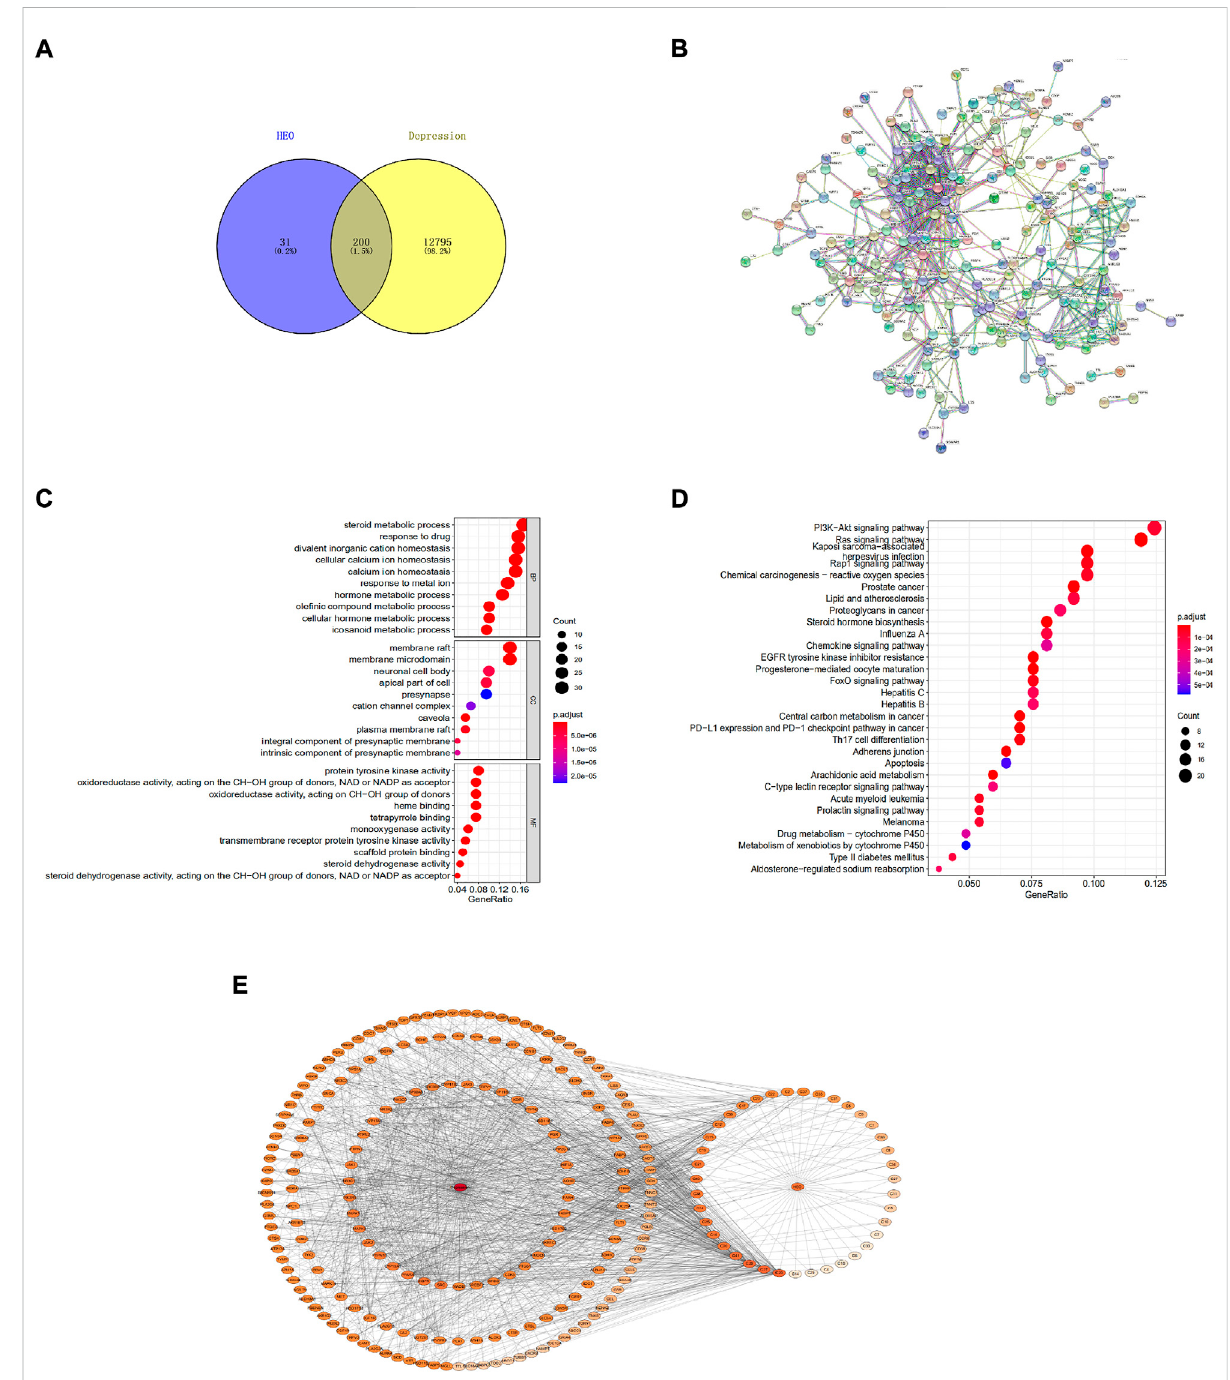
FIGURE 7 The network pharmacology method was adopted to predict potential mechanisms of HEO on depression. Venn diagram of depression- associated targets and predicted targets of active components (A) ; Protein-protein interaction network (PPI) of target proteins (B) ; Bubble chart of GO functions enrichment (C) ; Bubble chart of KEGG pathways analysis of overlapping target genes (top 20) (D) ; Drug-molecular-target-disease network diagram (E) . The color of nodes represents the degree ’ s value, and the deeper color represents a greater interaction